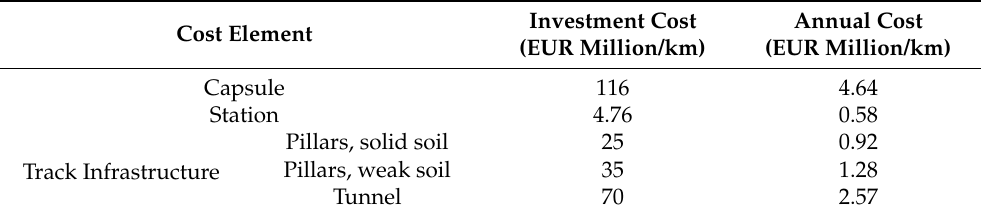
Table 3. Analysis of the passenger capacity for different capsule sizes [20].